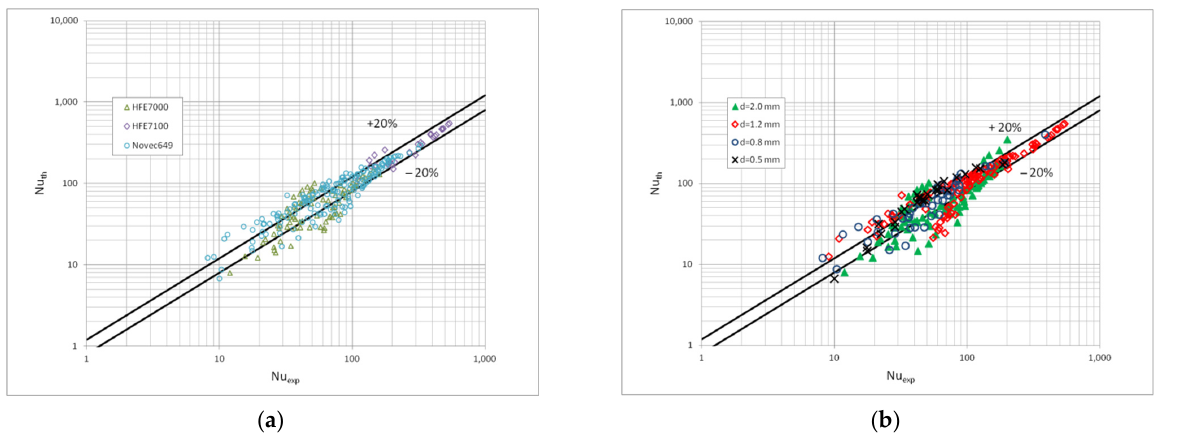
Figure 10. Comparison of the experimental investigation results of the HFE7000, HFE7100 and Novec649 refrigerants condensation in mini-channels which calculation results according to the correlation (1) for the dispersive structure; ( a ) for individual refrigerants, ( b ) for individual mini-channel diameters.